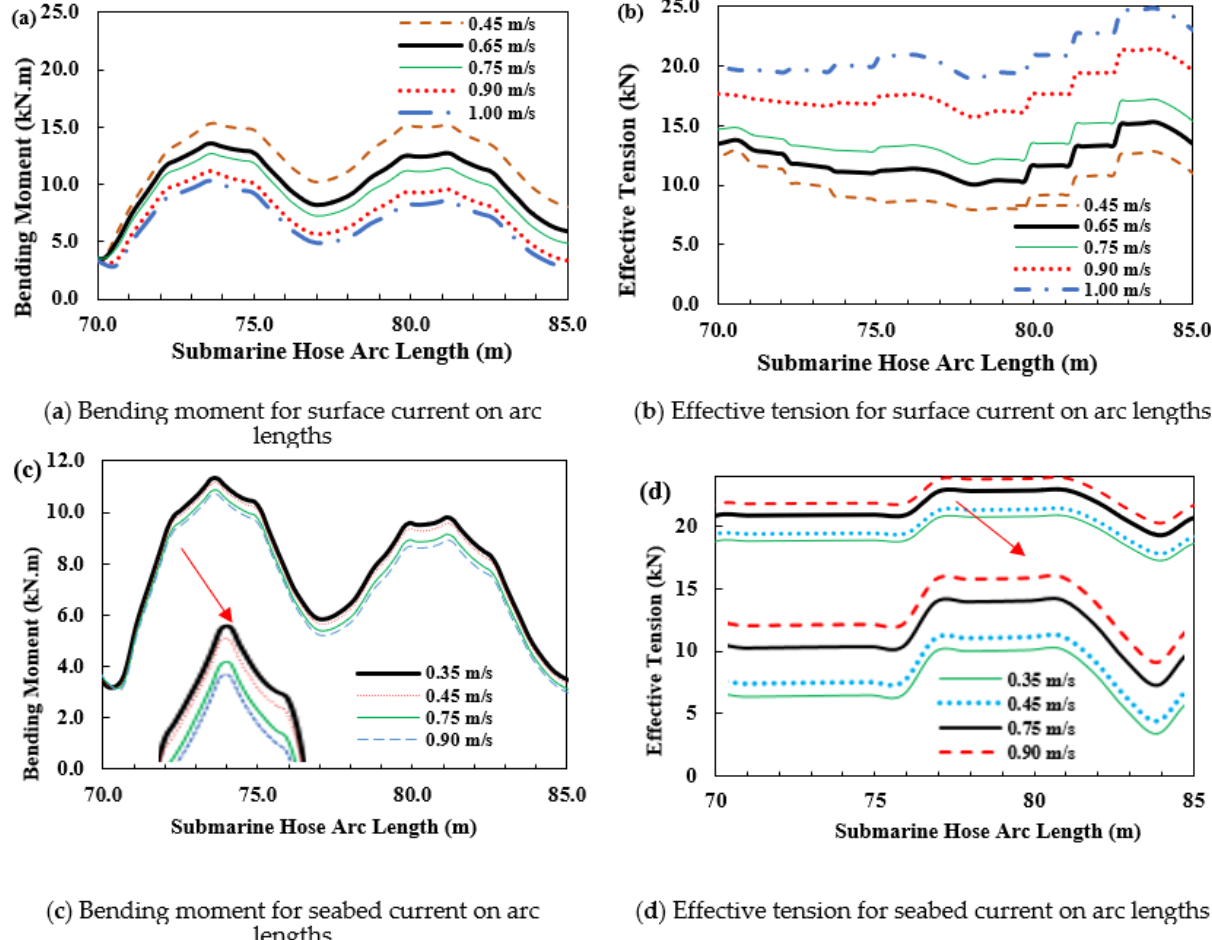
Figure 28. Influence of surface currents ( a , b ) and seabed currents ( c , d ) on submarine hoses.